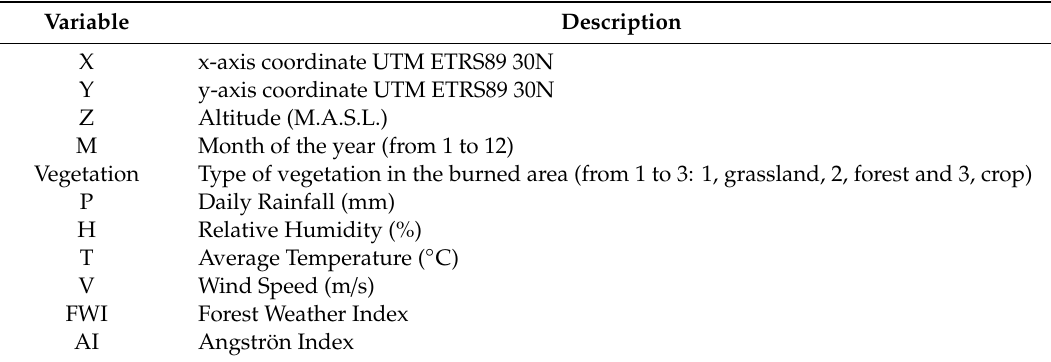
Table 2. Description of input